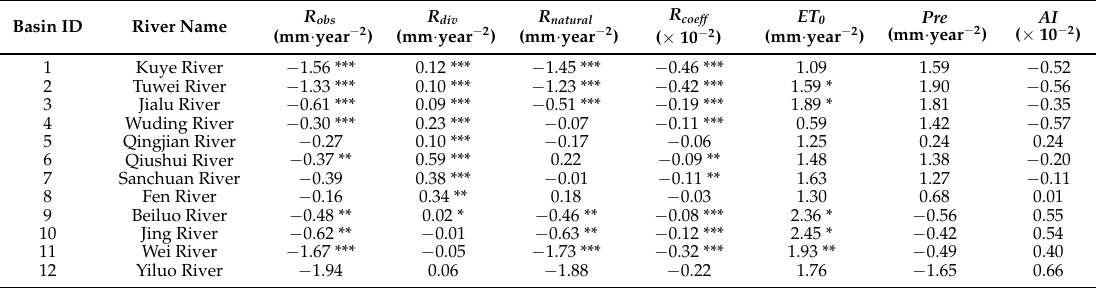
Table 2. Trends of runoff and climate factors from 1980 to 2013 in the 12 basins in the Loess Plateau. Basin ID